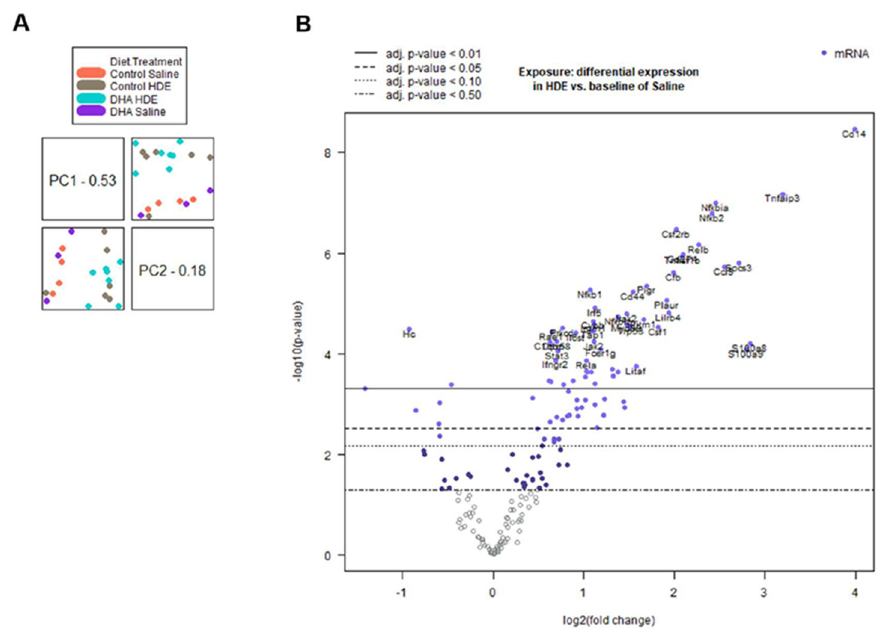
Figure 5. Principal component analysis and volcano plot of all 20 normalized samples. ( A ) Principal component analysis (PCA) and PCA scores displaying an overall strong clustering of related biological sample replicates for all 20 samples. ( B ) Volcano plot of expressed genes for the interaction between HDE and saline exposure among all 20 samples. p -value for volcano plot displayed as adjusted p -value. The numbers of statistically significant ( p ≤ 0.05) genes that were di ff erentially regulated of the 561 possible genes expressed are summarized in Table 2. As mentioned in the methods, genes below the 82-count threshold were removed from the analyses. Table 2. Breakdown of di ff erential expression for statistically significant genes from each experimental group.